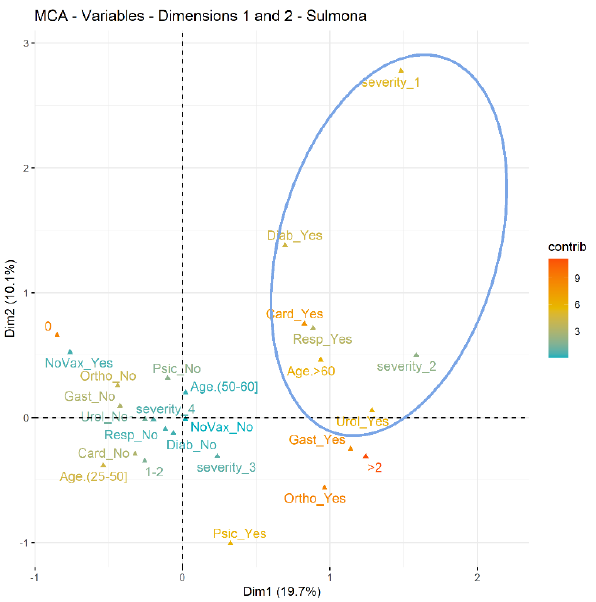
Figure 2. Sulmona Prison.